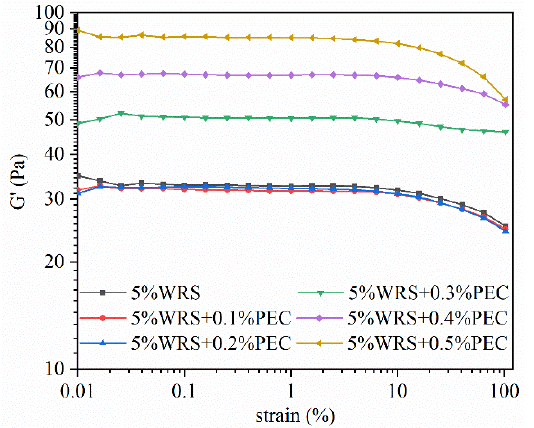
Figure 1. Strain sweep curves of the WRS and the WRS–PEC mixtures (frequency was set to 1